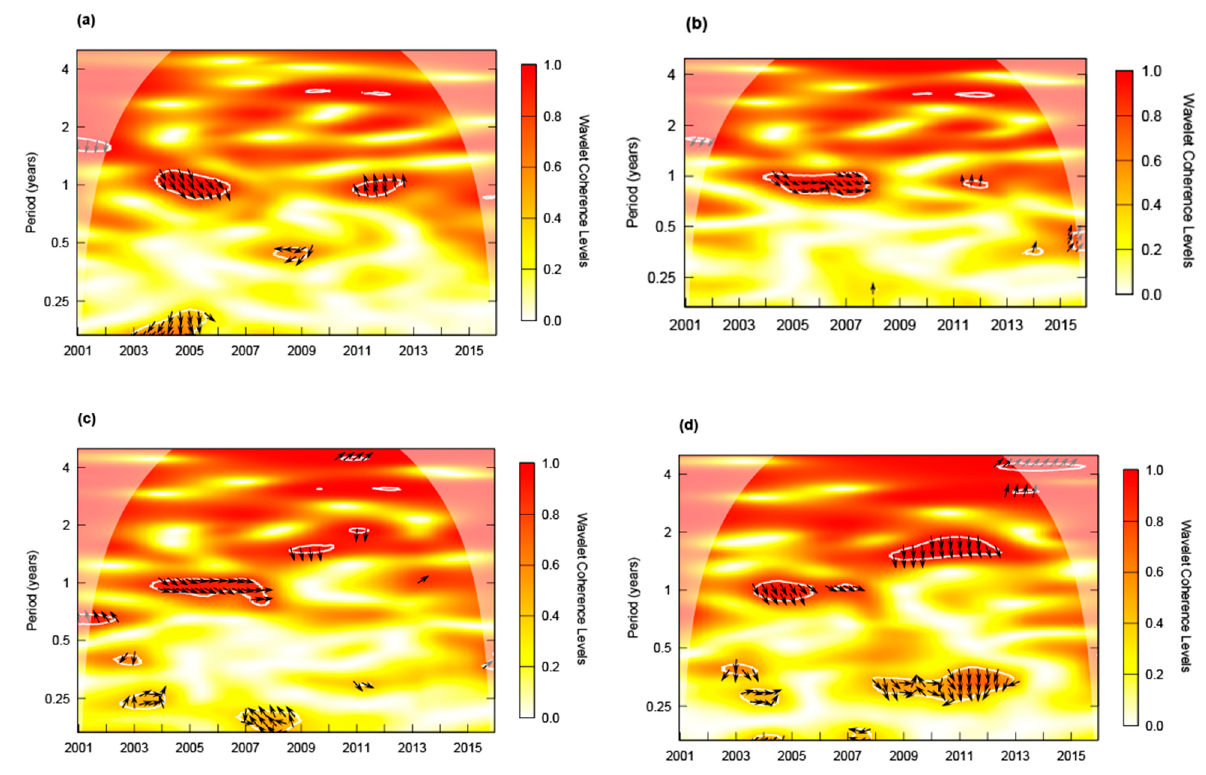
Figure 6. Wavelet coherence between ENSO–NDVI in 2001–2015. ( a ) Niño 1 + 2–NDVI, ( b ) Niño 3–NDVI, ( c ) Niño 3.4–NDVI, ( d ) Niño 4–NDVI.